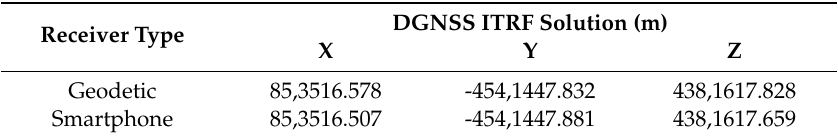
Table 2. Geodetic receiver and smartphone DGNSS solutions.